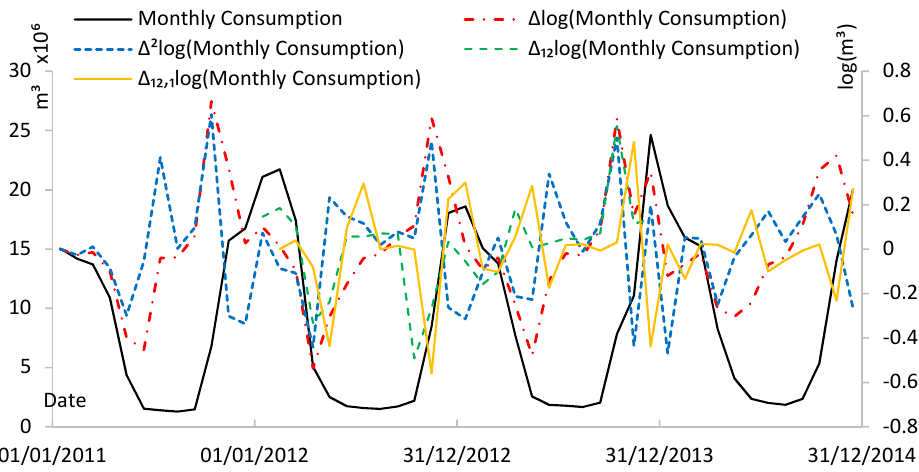
Figure 3. Consumption with integrated series.